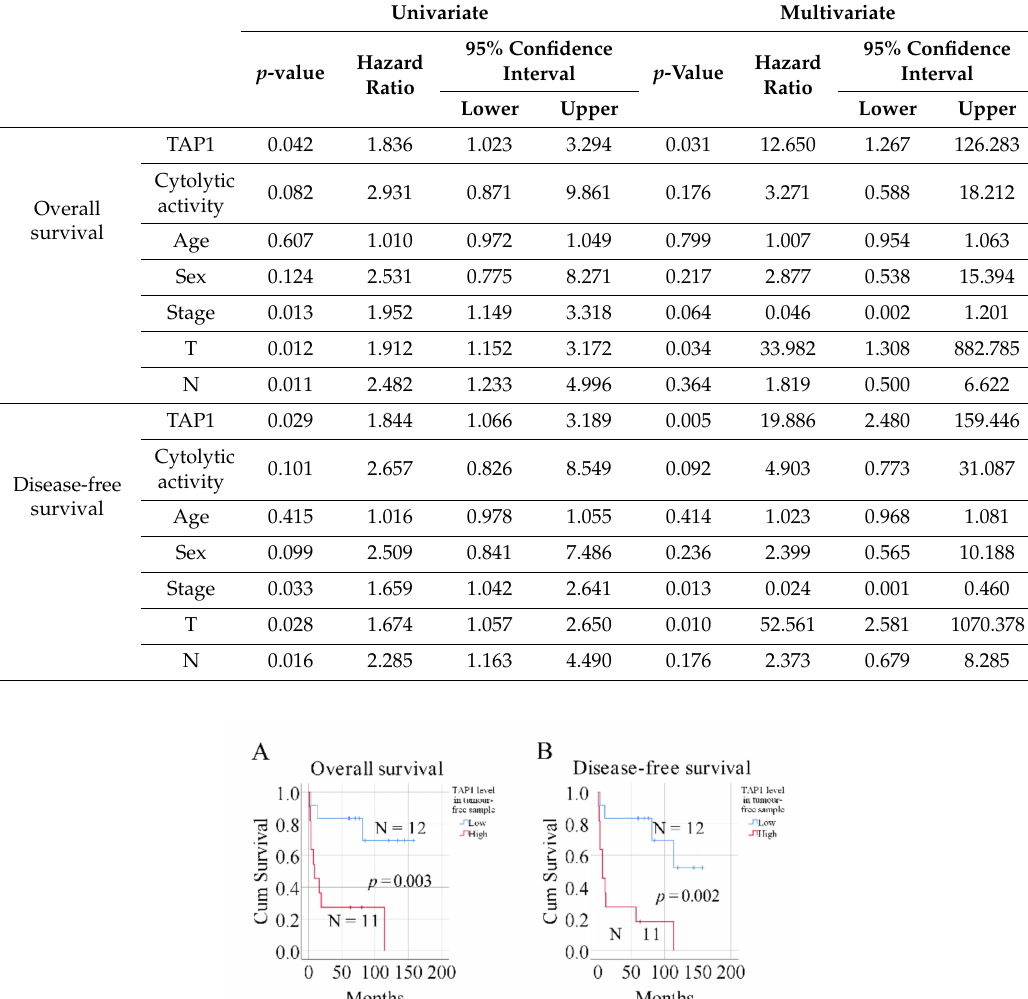
Table 2. Univariate and multivariate Cox regression analysis of risk factors for survival.